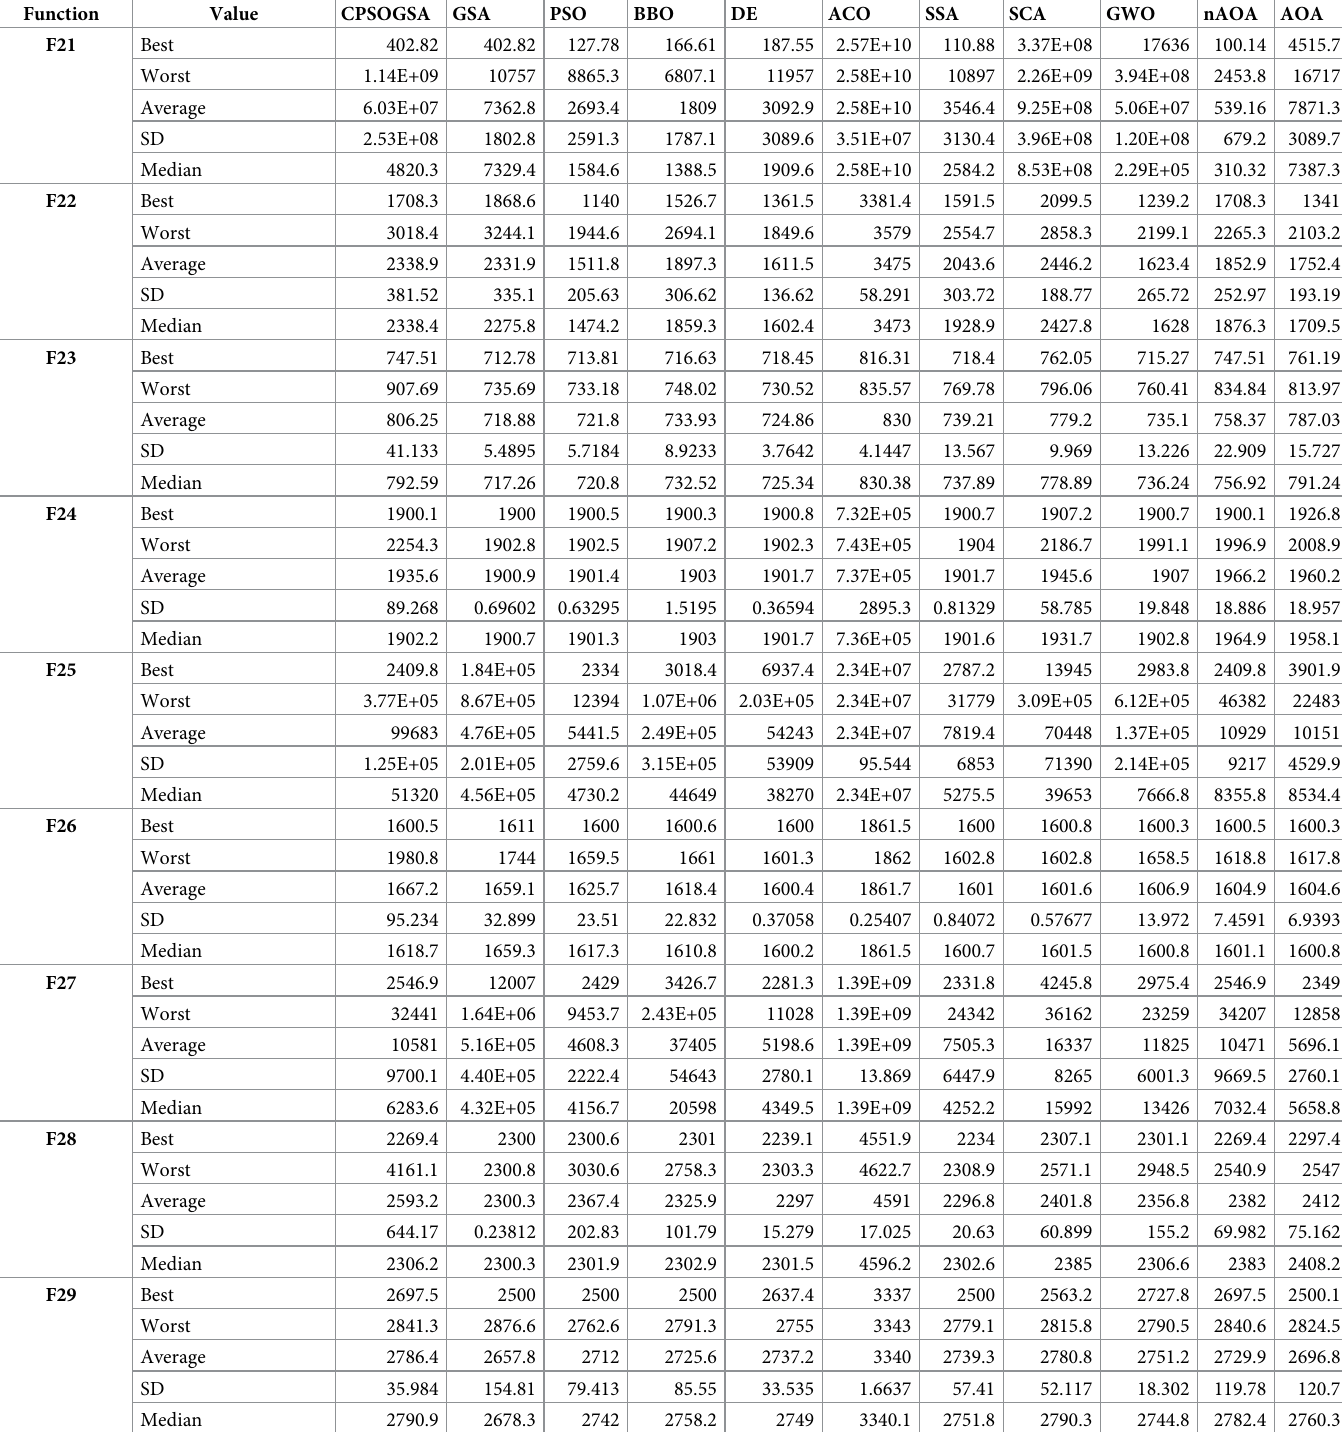
Table 5. Composite functions CEC